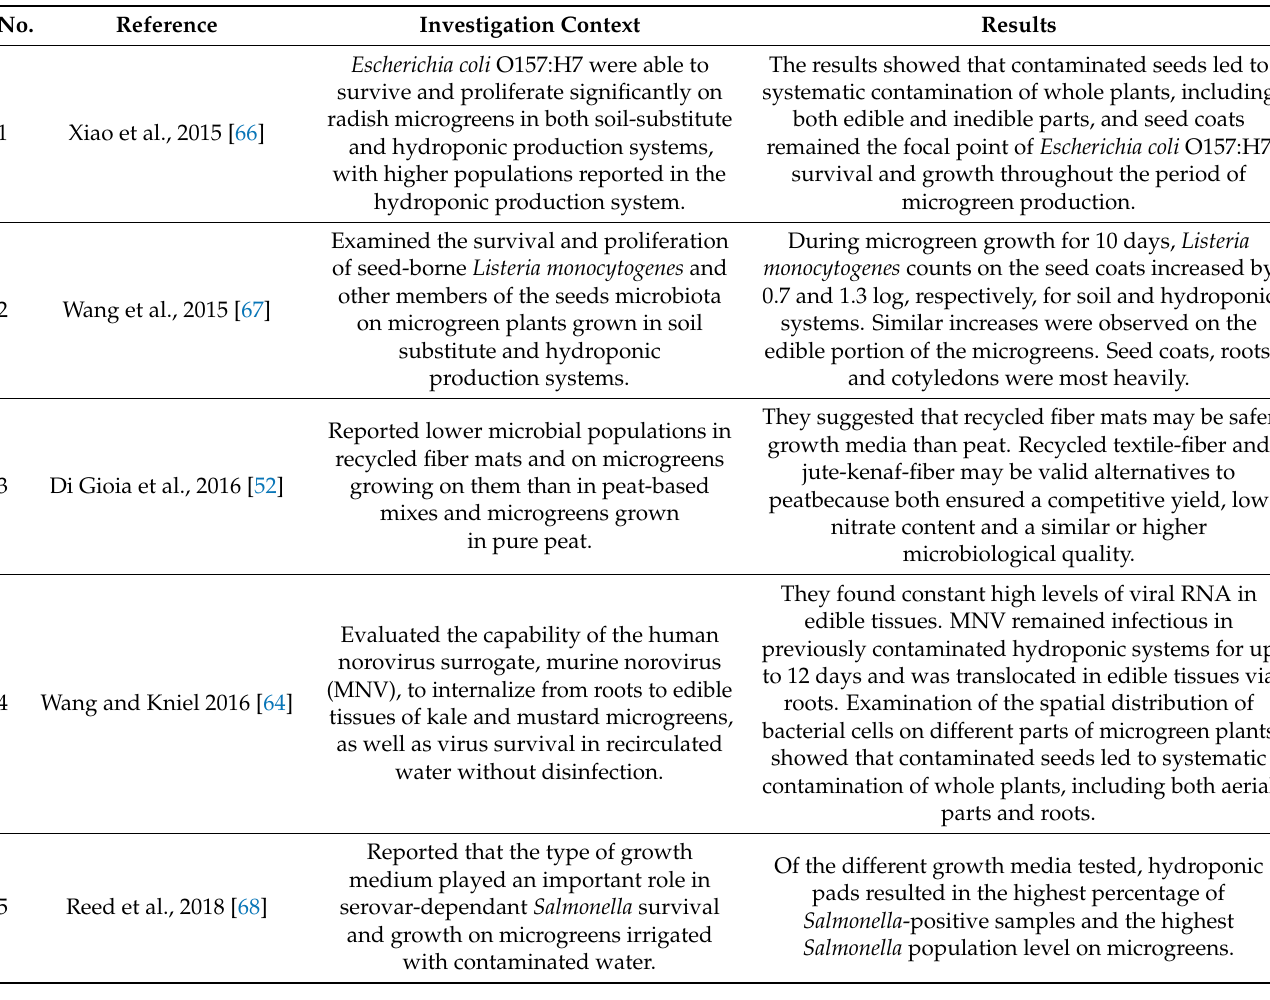
Table 3. Studies showing the possibility of microgreen